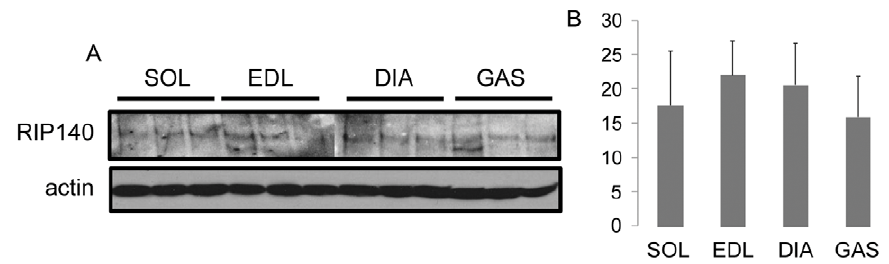
Figure 1. RIP140 protein level is the same in oxidative and glycolytic muscles. (A) Analysis of soleus (SOL), EDL, diaphragm (DIA), and gastrocnemius (GAS) protein extracts by western-blot for RIP140 and actin expression. (B) Quantification of the western-blot for RIP140. Data are expressed as mean 6 SEM.